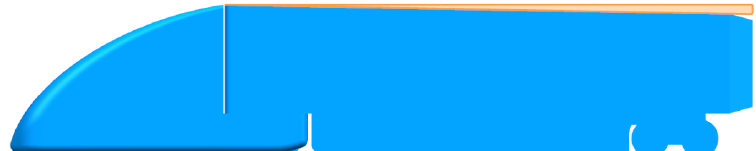
Fig. 20. Concept Two – Revision D, removed geometry for the tapered roof feature is highlighted in